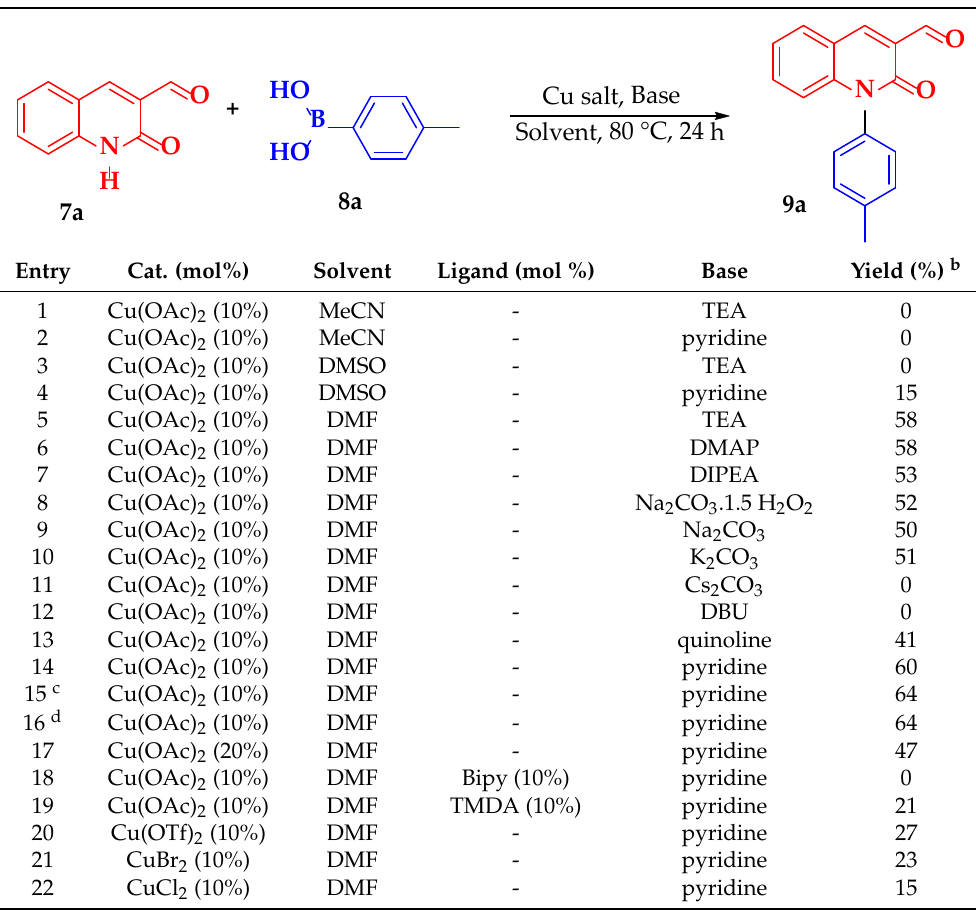
Figure 1. Crystal structure of 9a determined by single-crystal X-ray diffraction. Table 1. Optimization of the reaction conditions a Table 1. Optimization of the reaction conditions a .